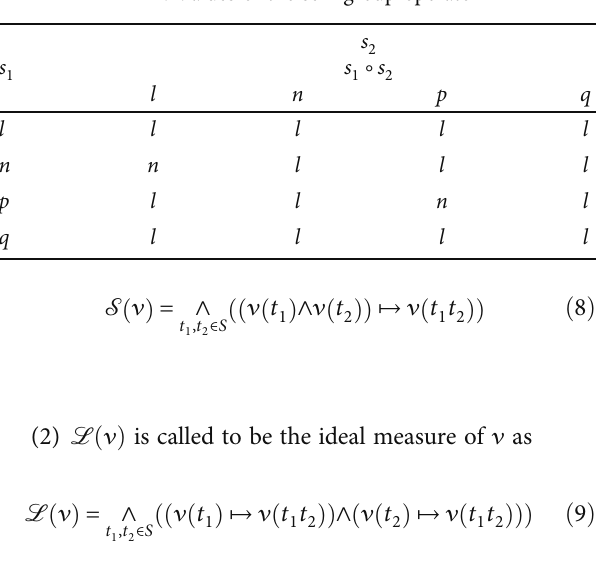
Table 1: Values of the semigroup operator ∘